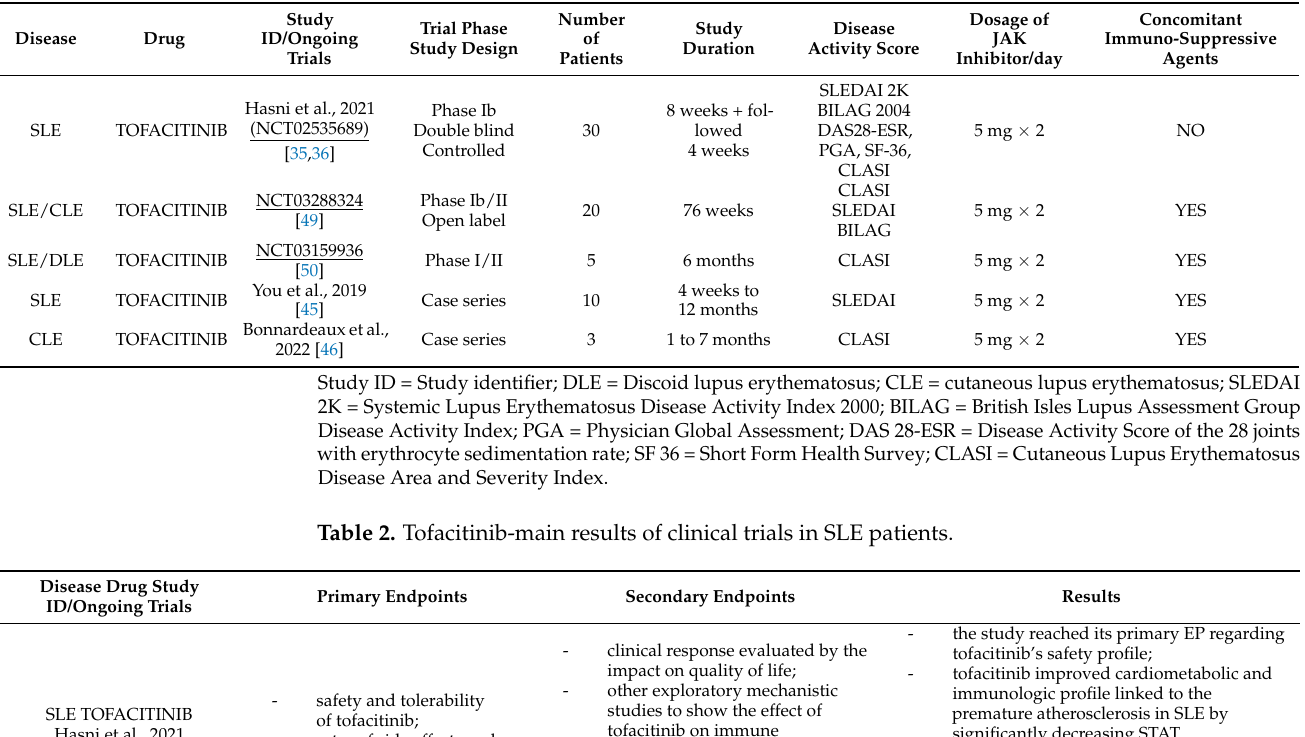
Table 1. Tofacitinib-main case reports and clinical trials.